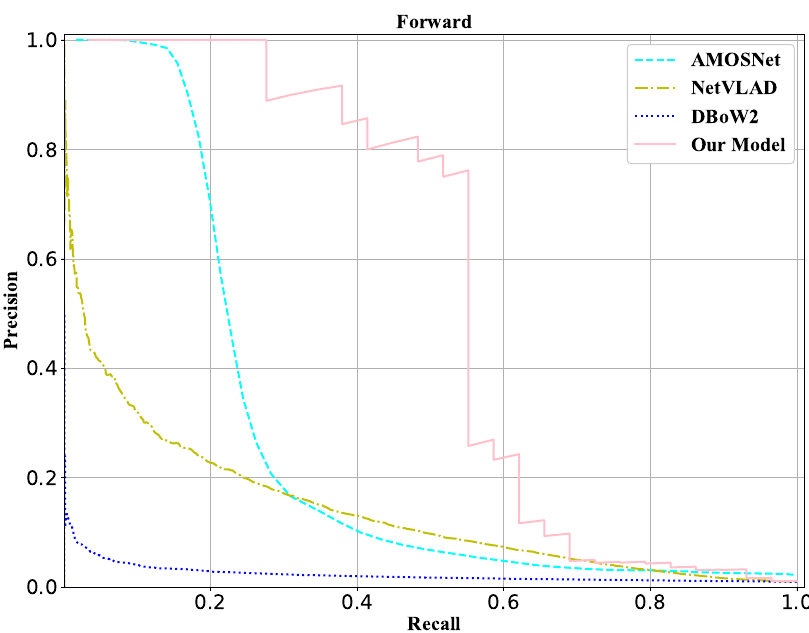
Figure 7. The Precision–Recall Curve comparison of the VPR models in “Forward view” sequence of the Airsim dataset.